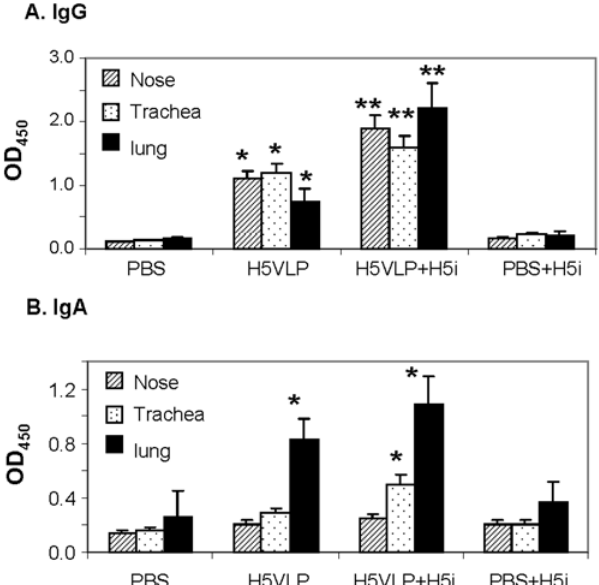
Figure 8. Mucosal antibody responses. A) Virus specific mucosal IgG. B) Virus specific mucosal IgA. H5VLP indicate a groups of mice (n=6 for each group) that was intranasally immunized with H5N1 VLPs containing 0.3 m g H5 HA at weeks 0 and 4. PBS is a mock control. H5VLP + H5i and PBS + H5i indicate additional groups of mice that were intranasally administered with inactivated rg D H5N1 virus (2.5 m g) 6 days earlier before euthanasia (in vivo viral antigen exposure). Nose, trachea, and lung samples from individual mouse were prepared in 200 m l, 200 m l, and 1000 m l PBS buffer respectively. Diluted samples (10 6 ) were used to determine antibody responses on ELISA plates coated with inactivated rg D H5N1 virus and optical densities were read at 450 nm. * p , 0.05 compared to the PBS control. ** p , 0.05 compared to H5VLP.